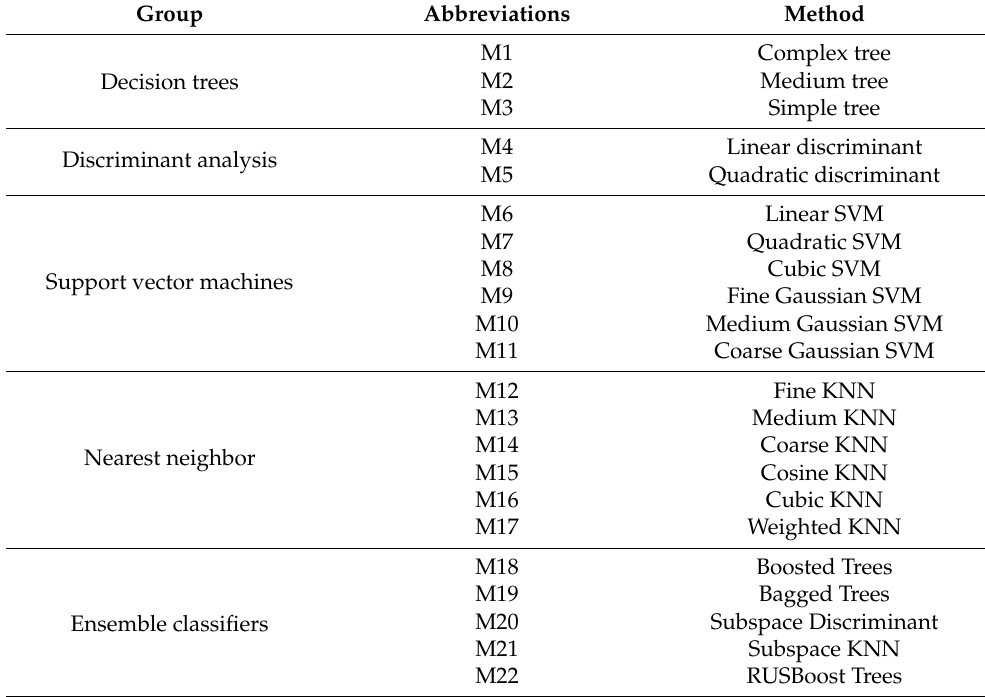
Table 2. The evaluated